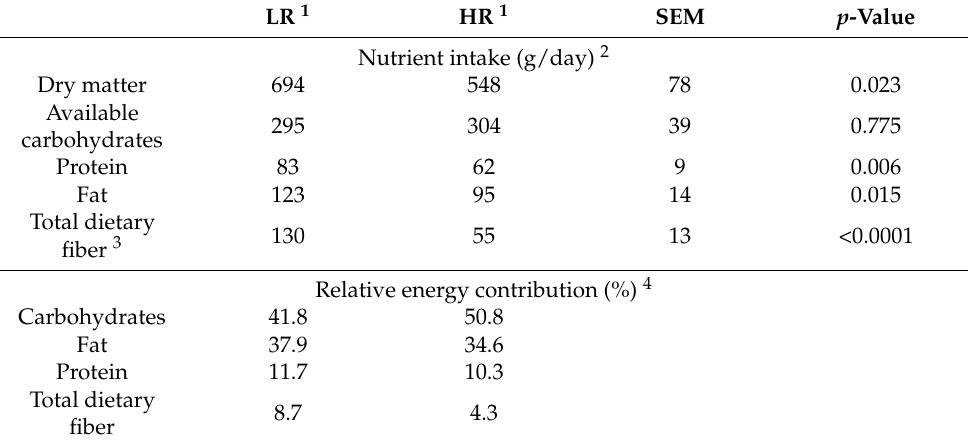
Table 2. Average nutrient intake over a 20-week intervention period and relative energy contribution of diet